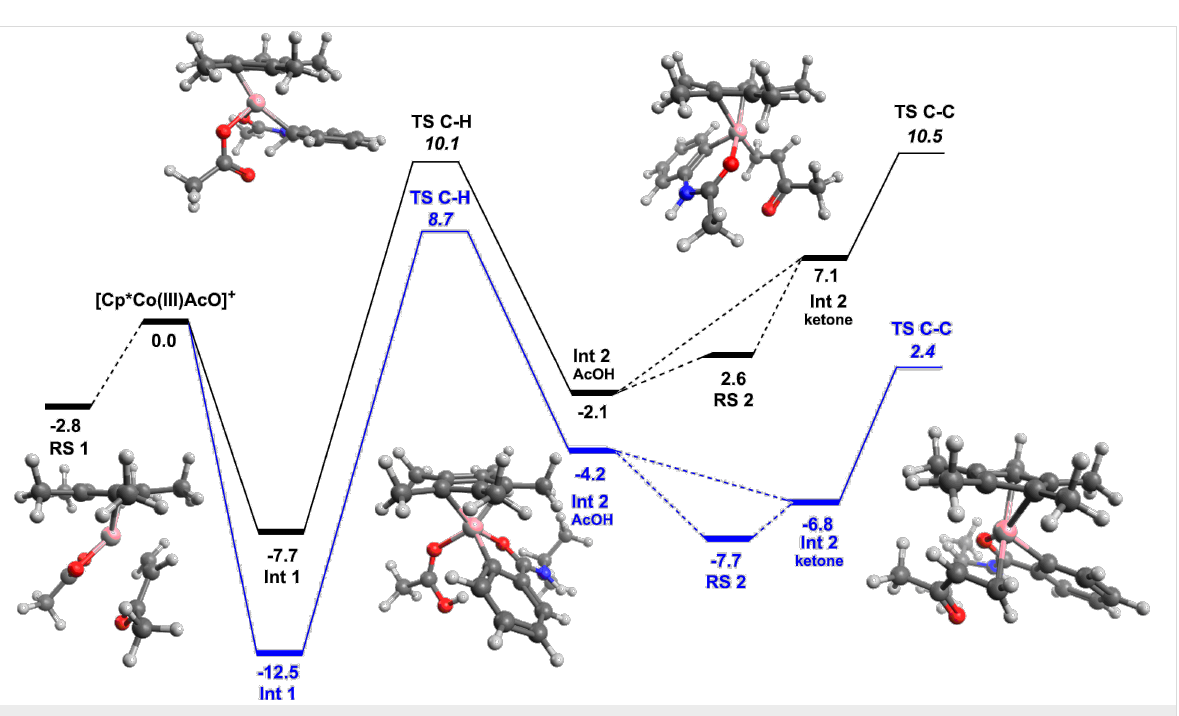
Figure 2: Comparison between energies during the Cp*Co(III)-catalysed coupling of 3-buten-2-one with acetanilide (black line) and benzamide (blue line); RS 1 is the direct interaction between the cationic [Cp*Co(III)AcO] + species and the 3-buten-2-one coupling partner and RS 2 is the interaction of the metallocycle intermediate with a second